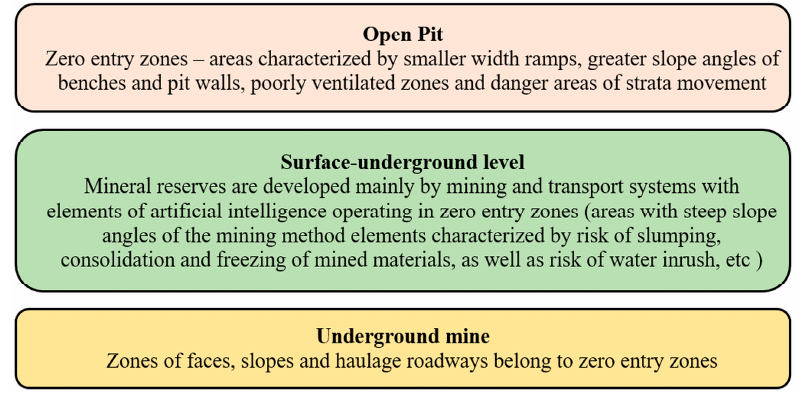
28 of 39 Figure 21. Schematic diagram of intelligent video surveillance technology (Reprinted from Ref. [116]). Installing Smart Sensors to control dump trucks traditional operation (by humans as the drivers) using artificial intelligence was very successful in Kuzbass—the largest coal basin in Russian Federation. Here are two cases of implementation of these Mining 4.0 technologies in this region [117]. The first case concerns avoiding the road accidents in surface mine (dump trucks collisions and roll-over) caused by drivers’ fatigue. Cameras and optical sensors with ma- chine vision, a vibration motor and a sound detector were installed on dump trucks at the Kuzbass surface mine (Western Siberia, Russia). Optical sensors located at the level of the driver’s eyes read the movement of a person’s gaze and head while the car is moving at a speed of more than 10 km/h. Artificial intelligence system analyzes the received data and makes a decision. If the driver is distracted, the system sounds a warning horn and acti- vates a vibration motor under the seat. If the driver does not respond to these signals within 8 s, the siren mode is turned on. The second case is related to the use of “smart assistants” for drivers of dump trucks, automating the following operations: Passing with oncoming mining equipment, moving in a convoy, crossing technological roads at night and in heavy weather conditions. Such systems complement the actions of the drivers, adjusting the position of the steering wheel, gas and brake pedals. The economic effect of introducing these artificial intelligence systems in traditional transport technology implied achieving zero accidents in three years of their use (2017– 2019). Based on the experience of 10 previous years, this allowed avoiding unforeseen